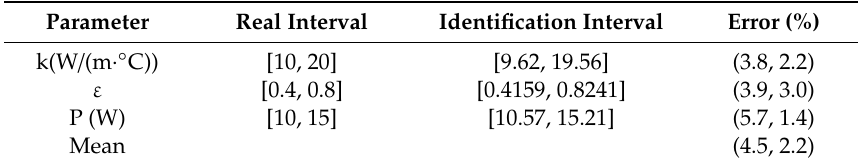
Table 1. Identified results of the box heat transfer system.